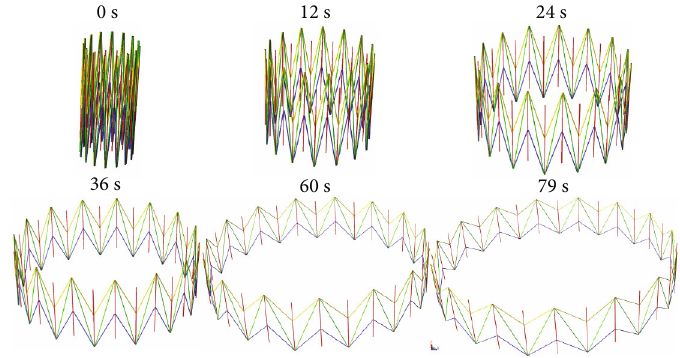
Figure 12: Deployment con fi gurations in the fi rst